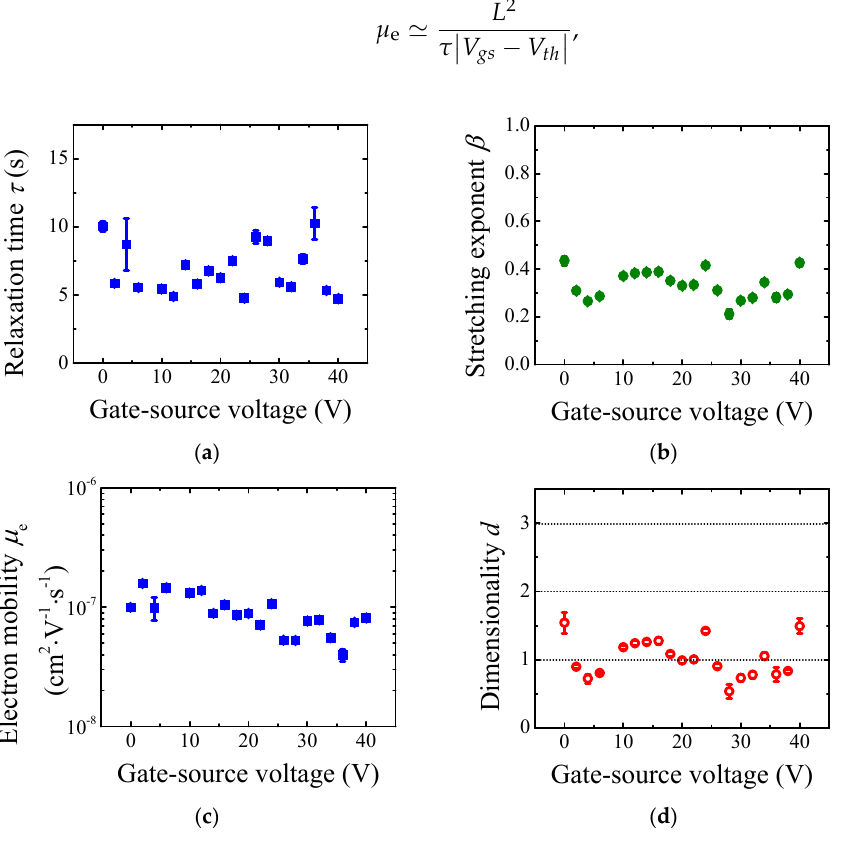
Figure 3. Fitting result of ( a ) relaxation time 𝜏 and ( b ) stretching exponent 𝛽 as a function of the gate ‐ source voltage. ( c ) Electron mobility 𝜇 (cid:2915) evaluated from relaxation time and ( d ) charge transport dimensionality 𝑑 evaluated from stretching exponent.